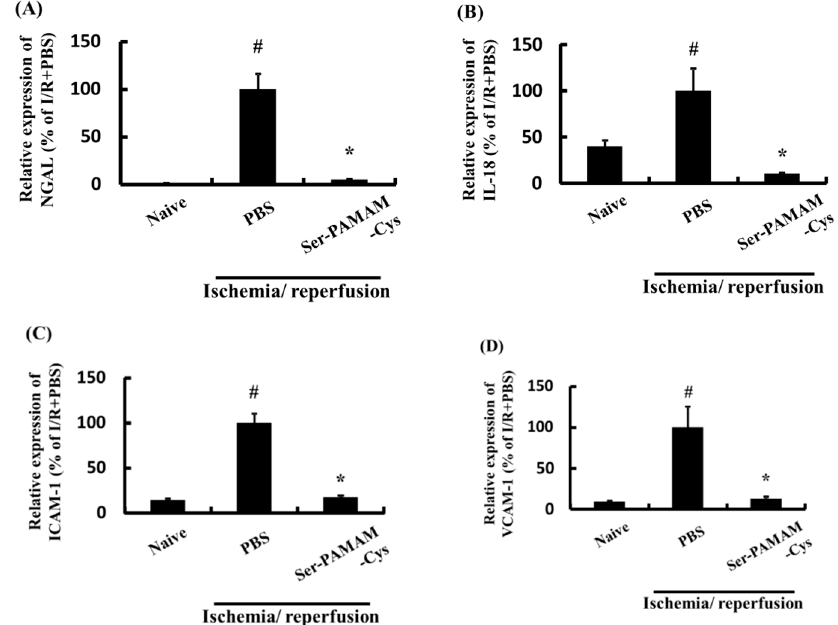
Figure 5. Effect of Ser-PAMAM-Cys on expression levels of ( A ) NGAL, ( B ) IL-18, ( C ) ICAM-1, and ( D ) VCAM-1 in mouse ischemia/reperfusion model kidneys. Results are expressed as means ± SE for five mice. # p < 0.05, significantly different from the naive group. * p < 0.05, significantly different from the ischemia/reperfusion (I/R) + PBS group.